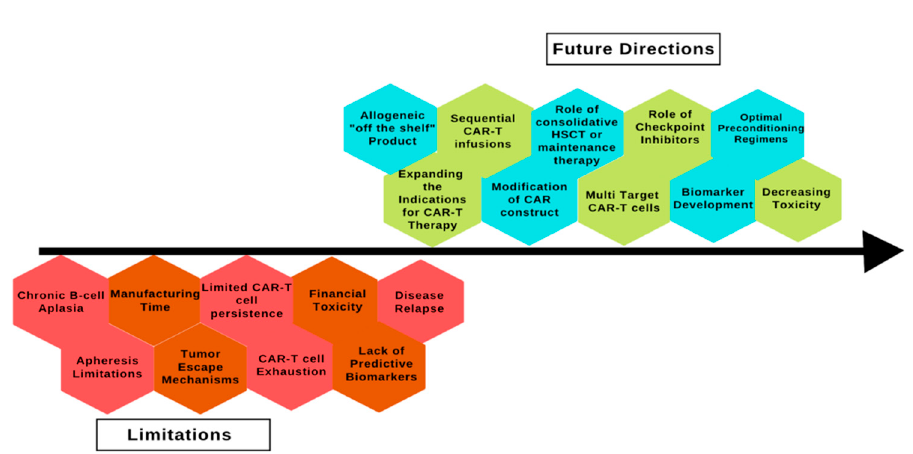
Figure 2. Limitations and future directions of chimeric antigen receptor therapy in acute lymphoblastic leukemia. CAR: chimeric antigen receptor; HSCT: hematopoietic stem cell transplant.